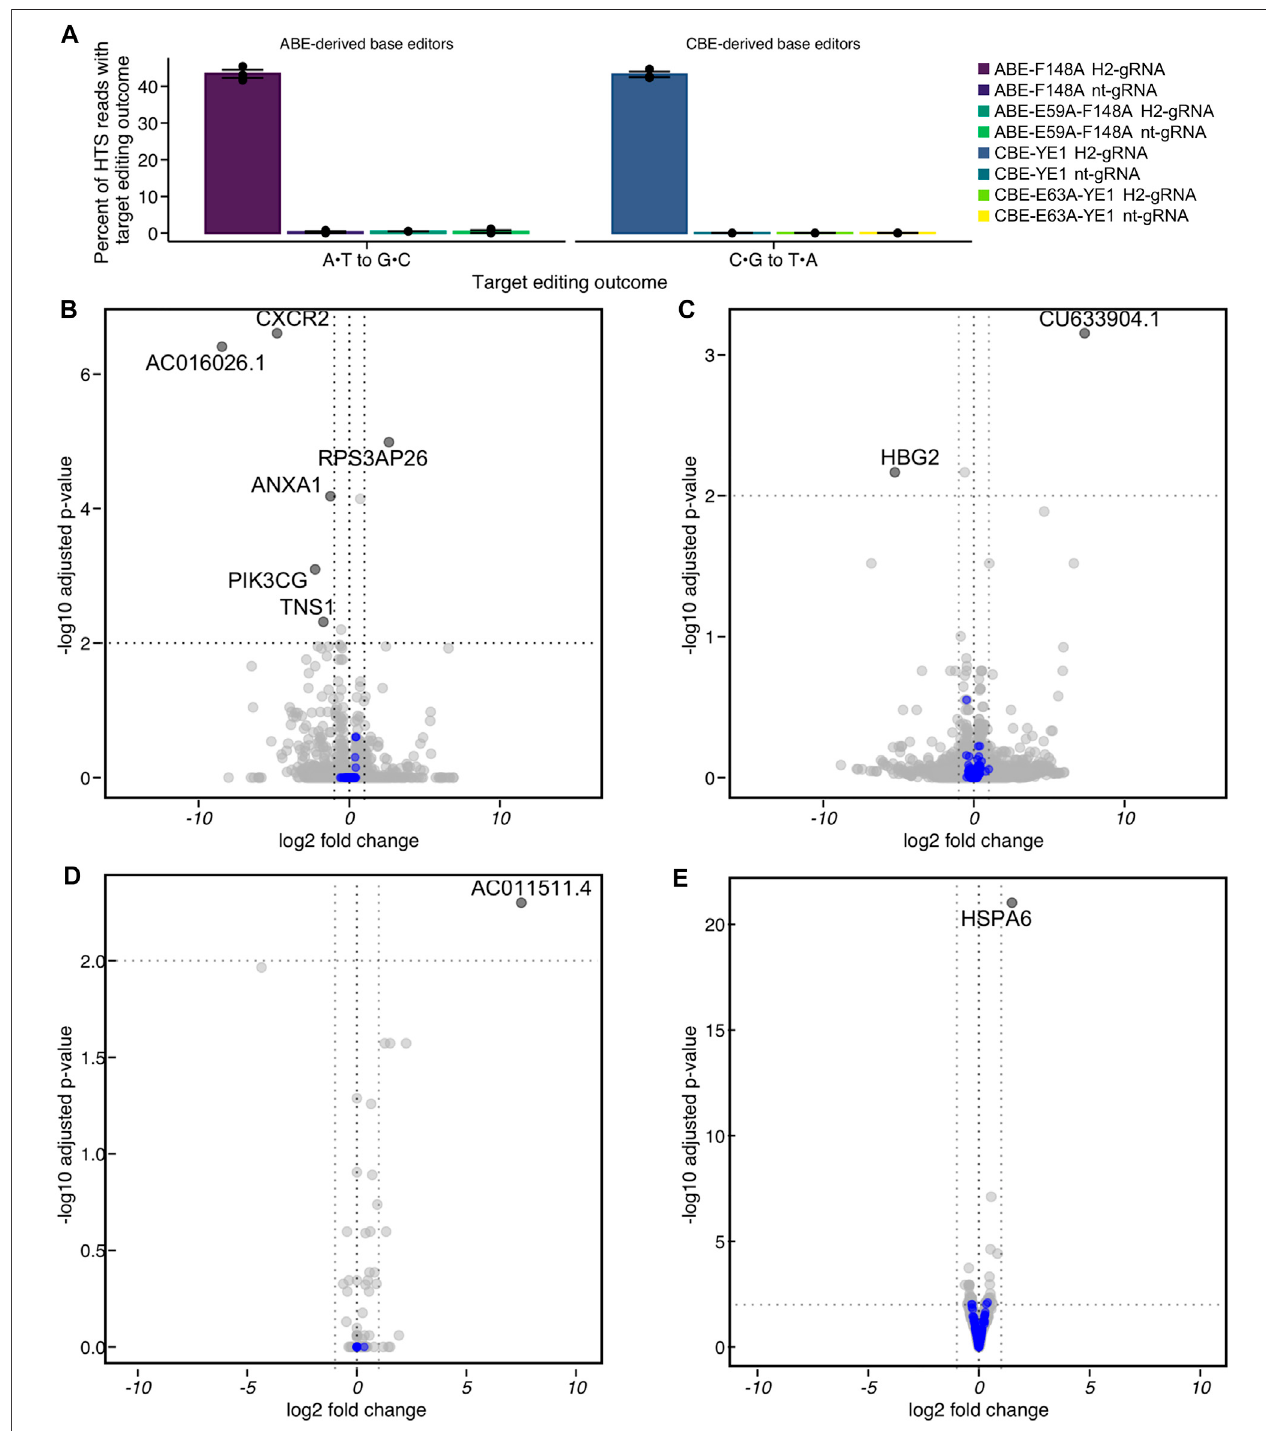
FIGURE5| Differentialexpression analysisofHEK293T cellsundergoing baseeditingatthe HEK2 (H2) genomic locusbyRNAoff-targetoptimized constructs. (A) HEK293T cells were transfected with the reduced-RNA editing variants ABE-F148A or CBE-YE1, or their catalytically inactivated deaminase counterparts ABE-E59A- F148A or CBE-E63A-YE1, CBE Δ UGI-E63A-YE1 and either a HEK2-targeting gRNA (H2-gRNA) or a non-targeting gRNA (nt-gRNA). At 48 h post-transfection, cells werelysed,thegenomic DNAwasextracted,and targetlociwereampli fi ed via PCRandsubjectedtoHTS.Genomeeditingef fi ciencies(percent oftotalHTSreads (cid:129) (cid:129) (cid:129) (cid:129) withthe target A T baseconverted toG Cfor ABE variants, or percent oftotalHTS reads withthe target C Gbase converted toT A forCBE variants) were quanti fi ed withCRISPResso2. Shownareoverallbaseeditingef fi cienciesforallsamples. (B – E) HEK293Tcellsweretreatedidentically, but at48 hpost-transfection,theRNAwas ( Continued )